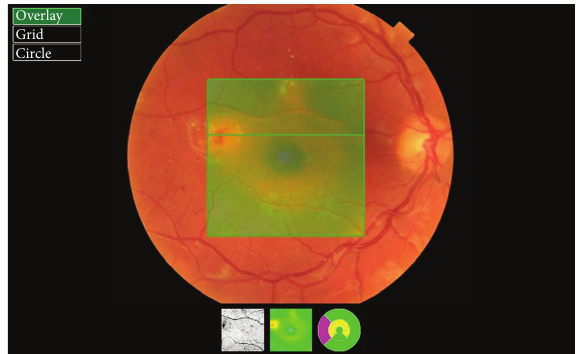
Figure 2: Retinal thickness map—patient from Figure